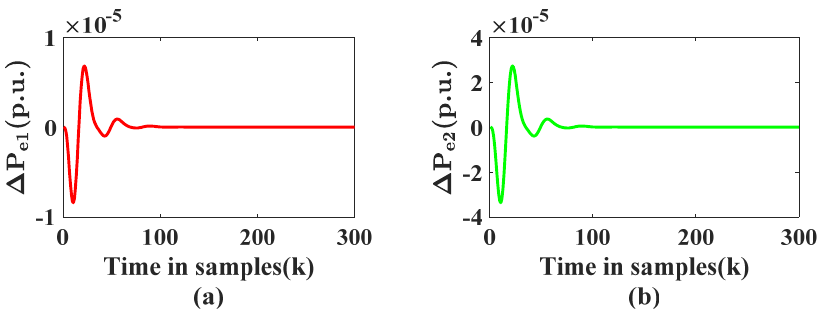
Figure 6. Output power deviation signal ∆ P e of wind turbines under the PSO-MPC strategy with wind turbines. ( a ) Output power deviation under ∆ P L 1 ; ( b ) Output power deviation under ∆ P L 2 .